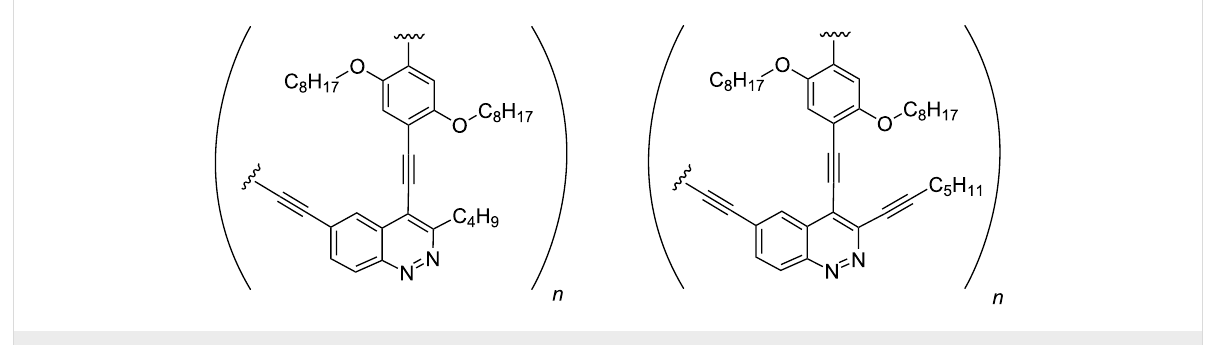
Figure 2: Target structures of